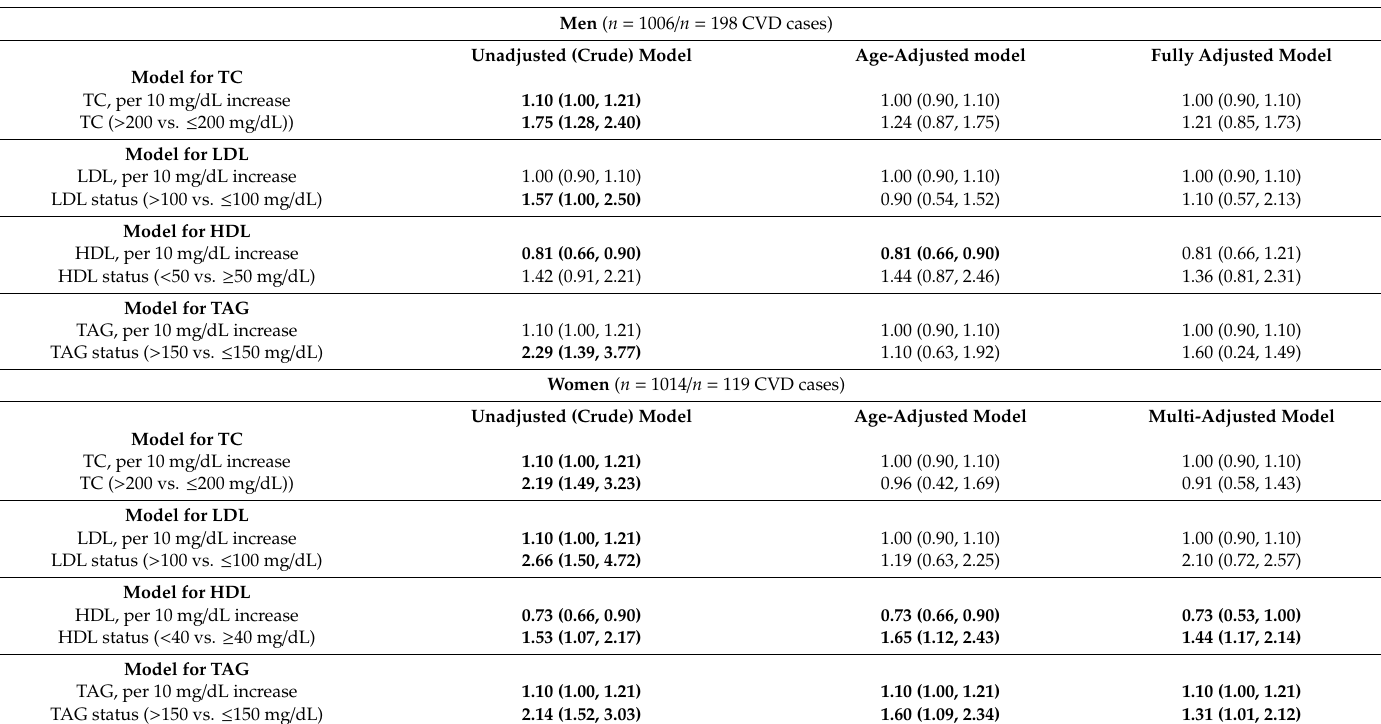
Table 2. Cox regression analysis to evaluate the association between conventional lipid markers and 10-year first fatal / non fatal cardiovascular disease incidence in apparently healthy men and women ( n =